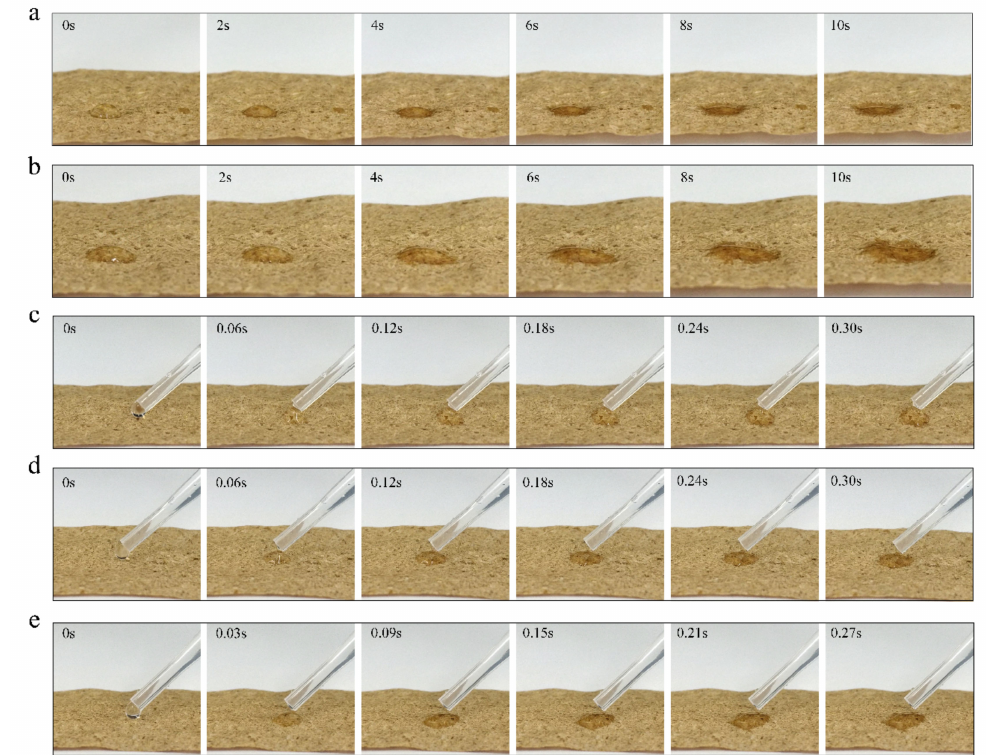
Figure 4. Infiltration of water droplets on the reconstituted tobacco paper-base surface with different plasma treatment time: ( a ) 0 s, ( b ) 5 s, ( c ) 10 s, ( d ) 15 s, and ( e ) 20